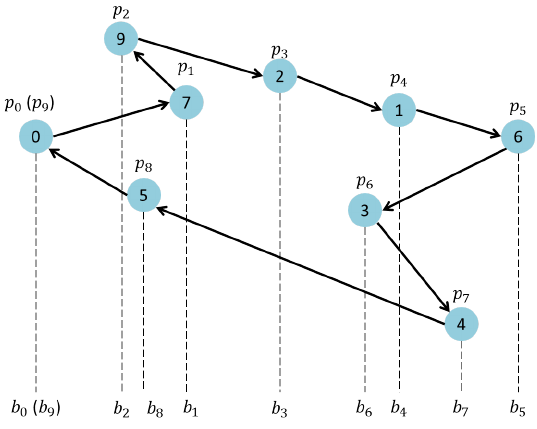
Figure 1. A demonstration of a principal agent route principal r = { p i | 0 ≤ i ≤ 9 } . Let b i = m 1 ( p 0 , p i ) , p i be sorted in the non-decreasing order based on b i , b 0 ( b 9 ) ≤ b 2 ≤ b 8 ≤ b 1 ≤ b 3 ≤ b 6 ≤ b 4 ≤ b 7 ≤ b 5